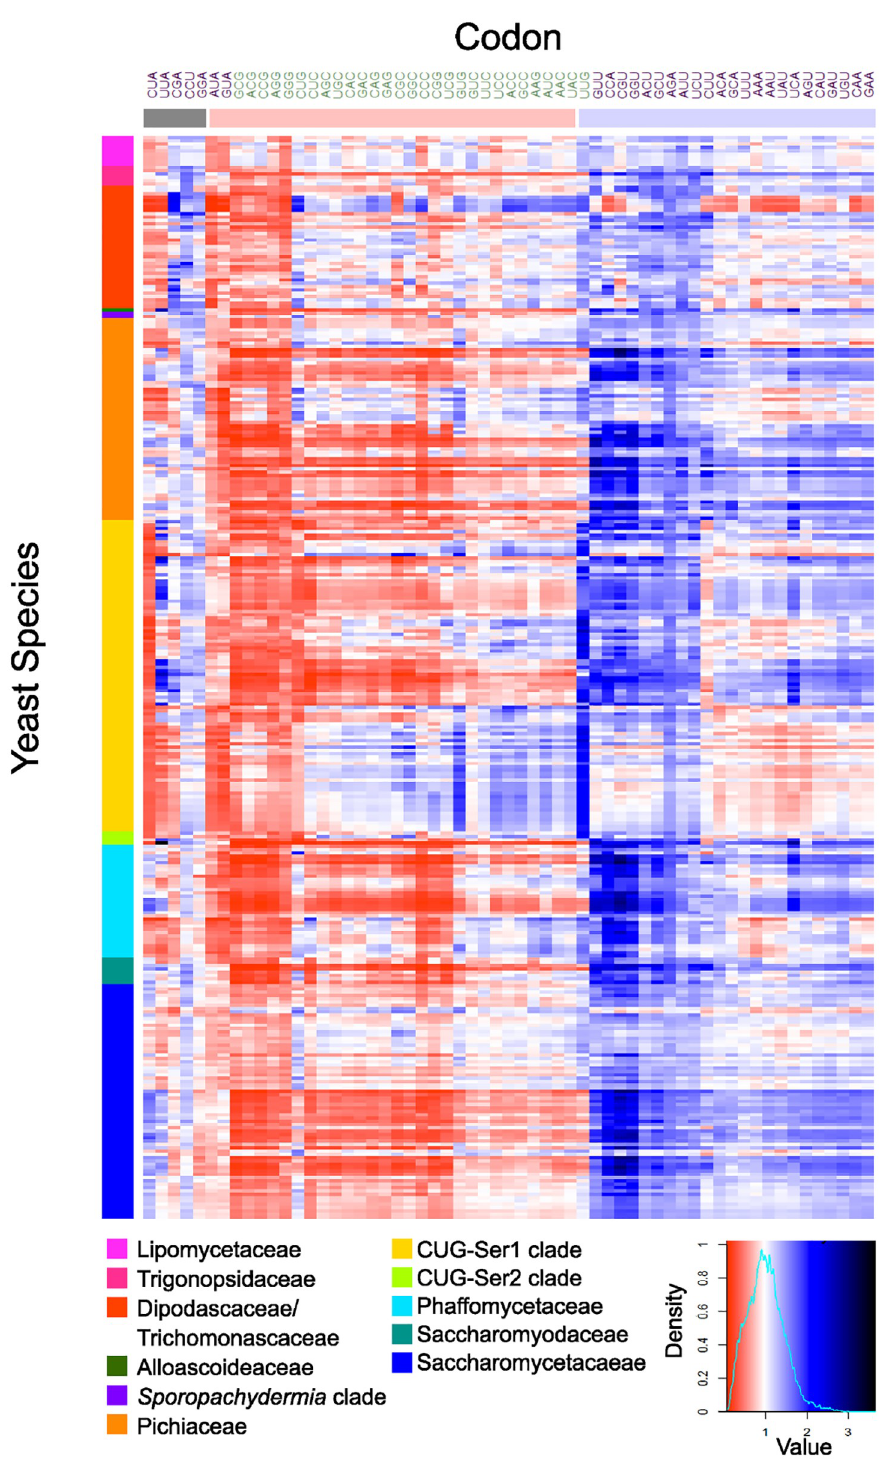
Fig 1. Relative synonymous codon usage (RSCU) analysis revealed an overrepresentation of A/Uending codons across most of the Saccharomycotina subphylum. Columns correspond to the 59 nondegenerate, non-stop codons; A/U-ending codons are shown in in purple font, and GC-ending codons are shown in green font. Rows correspond to the 327 Saccharomycotina species colored by major clade, following the recent genome-scale phylogeny of the subphylum [50]. Blue cells indicate overrepresented codons (RSCU > 1) and red cells indicate